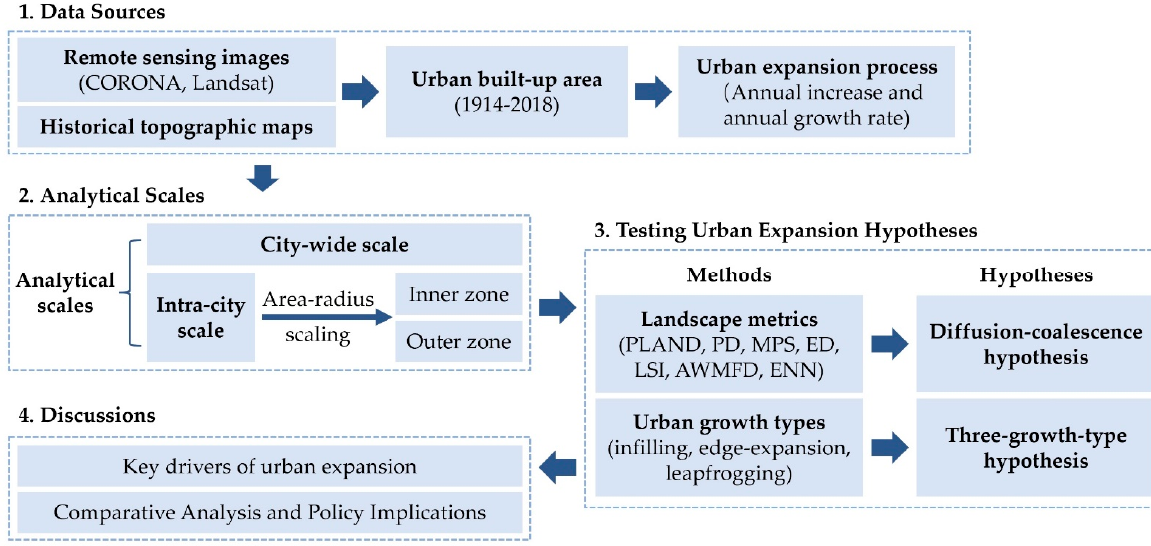
Figure 3. Research framework and steps.